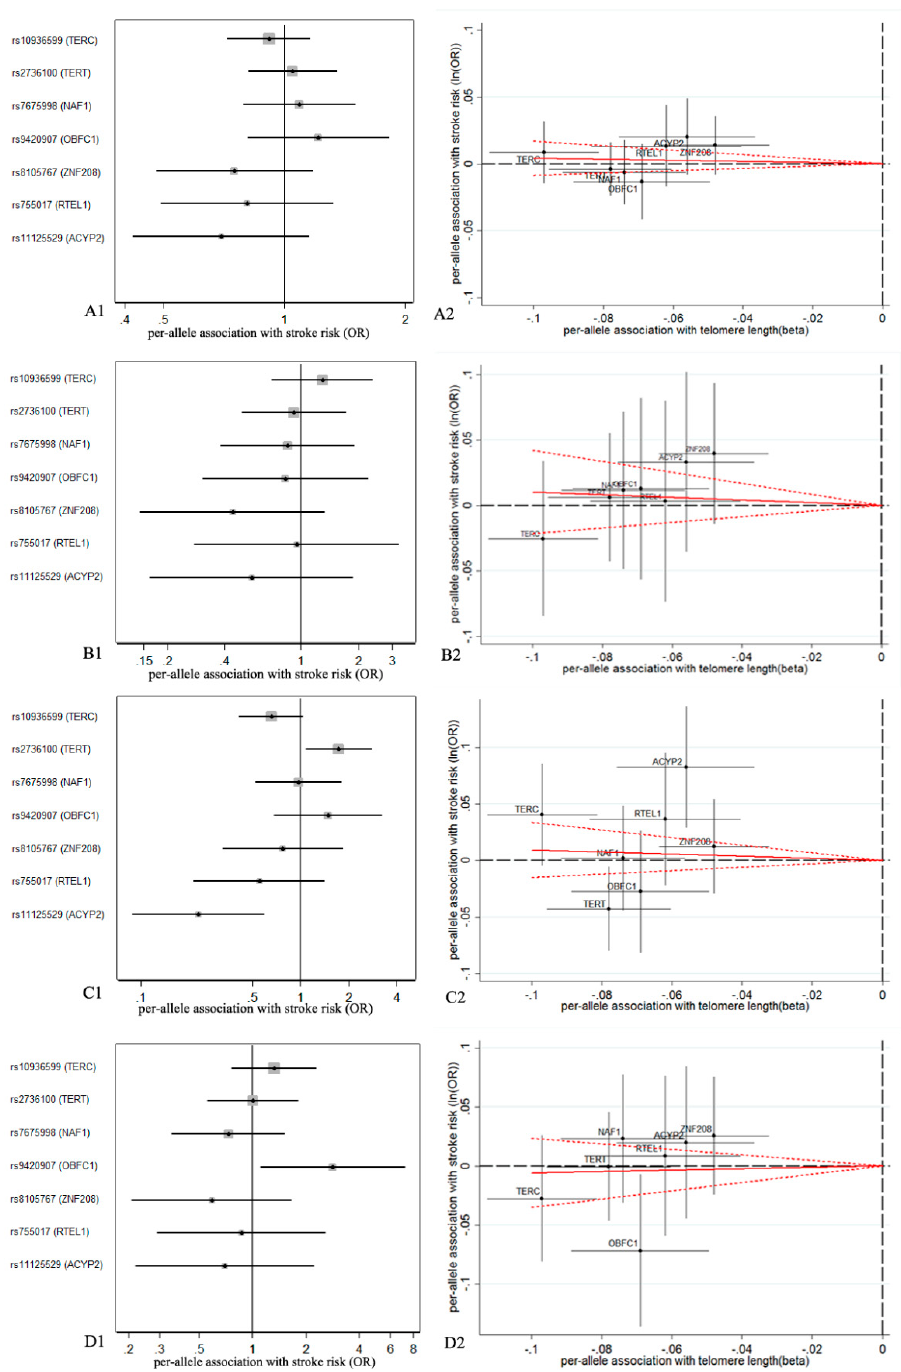
Figure 1. Forest plots and scatter plots of associations between telomere length (TL)-related single nucleotide polymorphisms (SNPs) and risk for all types and subtypes of ischemic stroke (IS). All ischemic stroke: ( A1 , A2 ); large artery stroke: ( B1 , B2 ); cardioembolic stroke: ( C1 , C2 ); small vessel stroke: ( D1 , D2 ). Forest plots ( A1 , B1 , C1 , D1 ) show the odds ratio (OR) with a horizontal line representing 95% confidence intervals (CIs) for the ‘short telomere’-associated SNP allele for stroke risk. Scatter plots ( A2 , B2 , C2 , D2 ) show the per-allele association with stroke risk plotted against the per-allele association with one standard deviation of TL (with vertical and horizontal black lines showing the 95% CI for each SNP). The slope of the red solid line (with dotted lines showing the 95% CI) in the scatter plots corresponds to the Mendelian randomization (MR)